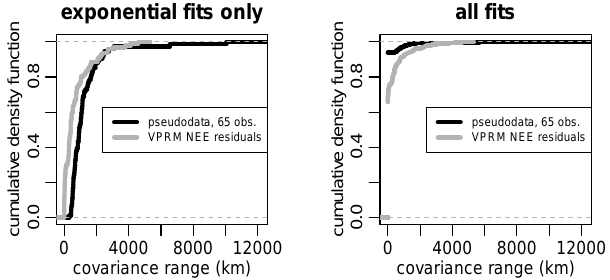
Fig. 5. Cumulative density functions for covariance range param- eter, estimated by maximum likelihood estimation (MLE). Each panel shows range values for seasonal VPRM NEE residuals (val- ues in Table 3) along with values from 1000 Gaussian random fields (GRFs) with similar (and known) covariance structure. The left panel shows the range distribution for only the pseudodata range estimations where the exponential covariance model fit more op- timally than the pure nugget; the right panel shows the distribution for all 1000 GRFs and demonstrates that the spread of best-fit ranges from the pseudodata experiment is quite similar to the spread among real VPRM residuals.